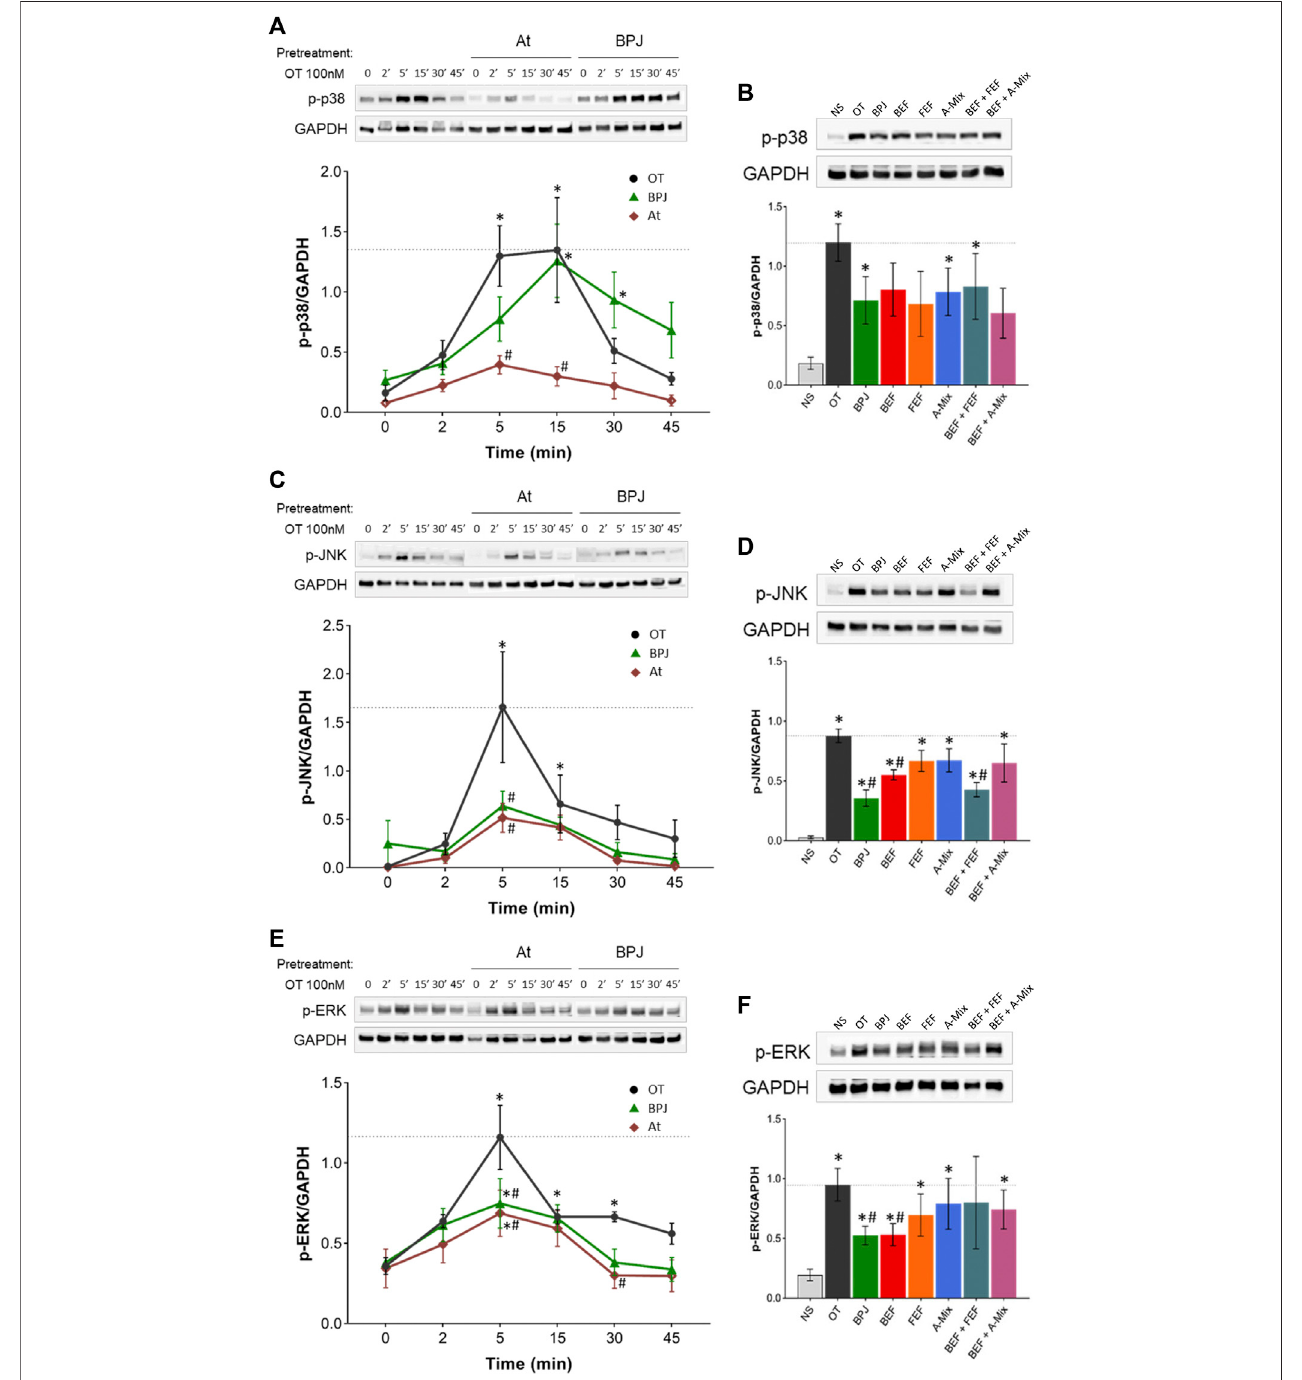
FIGURE 4 | Effect of BPJ fractions/compounds and atosiban on OT-induced MAPKs phosphorylation. In the time-course experiments, hTERT-C3 cells were pre- treatedwithorwithout20mg/mL BPJor100nM atosibanfor30min,beforeincubation with100nM OTfor2,5,15,30,and 45min (A,C,E) .Tocomparetheeffectsof BPJandthevariousfractions/compounds,cellswerepre-treatedwith20mg/mLBPJ,2.20 μ g/mLBEF,17.39 μ g/mLFEF,0.68 μ g/mLA-Mix,BEFplusFEF,orBEFplus A-Mix (same concentrations as for single fractions) for 30 min before stimulation with OT for 5 min (B, D, F) . Whole cell proteins were subjected to western blot analysiswithantibodiesagainstphosphorylatedp38(A,B),SAPK/JNK(C,D)andERK1/2 (E,F) ;matchingdensitometryanalysesaredepictedbellowtherepresentative blots. Samples from the same experiment were processed in parallel and membranes were probed with GAPDH to con fi rm equal loading. Blot images are from a representative experiment, and line between bands delineate boundary between the gels that were cropped. Values represent the mean ± SEM of four independent experiments; * p < 0.05 compared with control; # p < 0.05 compared to OT-treated.